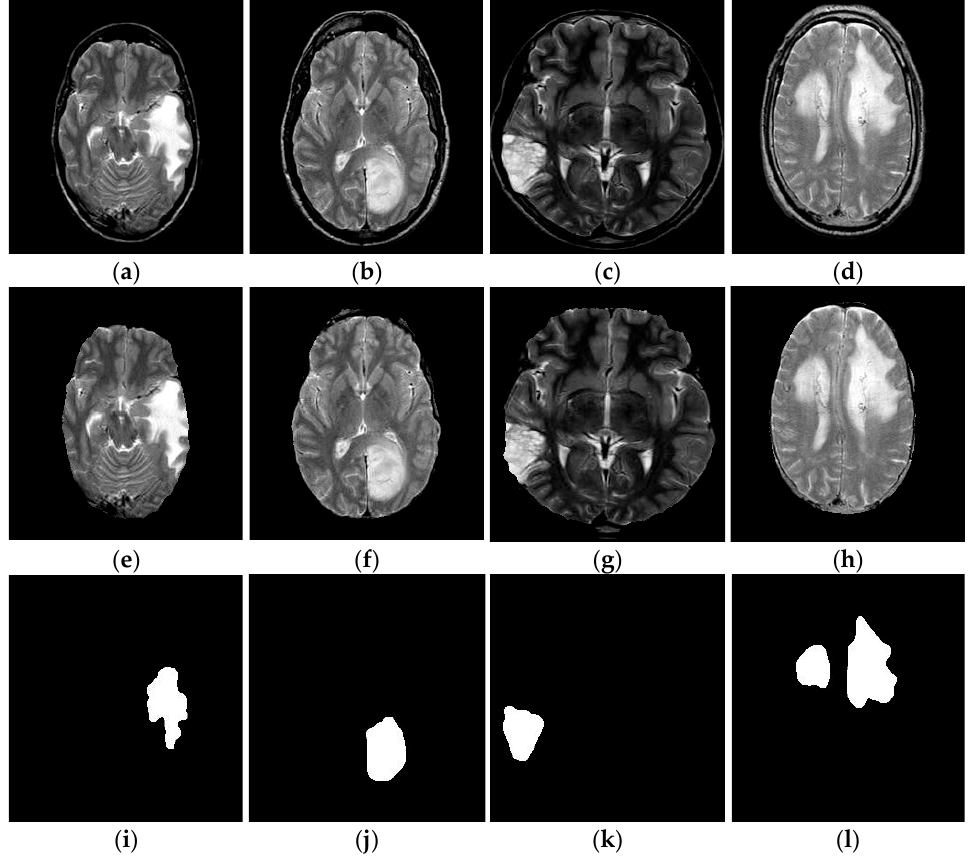
Figure 7. Outcomes of the proposed brain tumor segmentation: ( a – d ) Original brain tumor MR images. ( e – h ) Skull-stripped images. ( i – l ) Infected tumor region of the brain MR images by FL-MSCM.